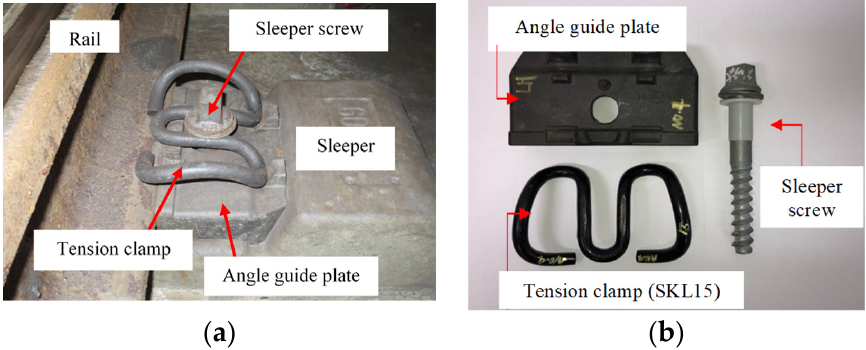
Figure 1. The DFF-300 rail fastening system: ( a ) An in situ photograph; ( b ) the main components. One year and five months after opening the urban railway in South Korea, 0.17% of the SKL15 tension clamps in the DFF-300 rail fastening system had been damaged. The SKL15 tension clamps were made from a spring steel, which had the minimum yield and tensile strengths of 1150 MPa and 1300 MPa, respectively [6]. As shown in Figure 2, the fracture surfaces of the damaged tension clamps showed the typical characteristics of a fatigue crack, which has an elliptical shape and a smooth surface. All of the cracked tension clamps were observed on the railroad with a curve radius ( R ) of 1200 m or less. Specifically, 79.1% of the damage occurred on the railroad with a curve radius of 800 m, and 94.5% of the cracked tension clamps were installed on the inner rail. The inner and outer rails can be divided into the inside and outside track gauges at the curved sections. Approximately 56% of the damage was found on the inside track gauge; Table 1 summarizes the statuses of the cracked tension clamps. Since the failure of the tension clamps is caused by fatigue, a fatigue reliability analysis was performed where most of the cracks occurred and the reasons for the tendency of fatigue cracks in the inner and outer rails were investigated. Figure 2. A fractured tension clamp.